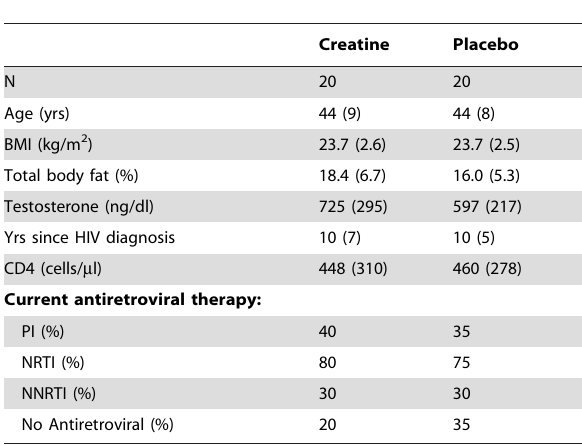
Table 1. Baseline Characteristics of the Study